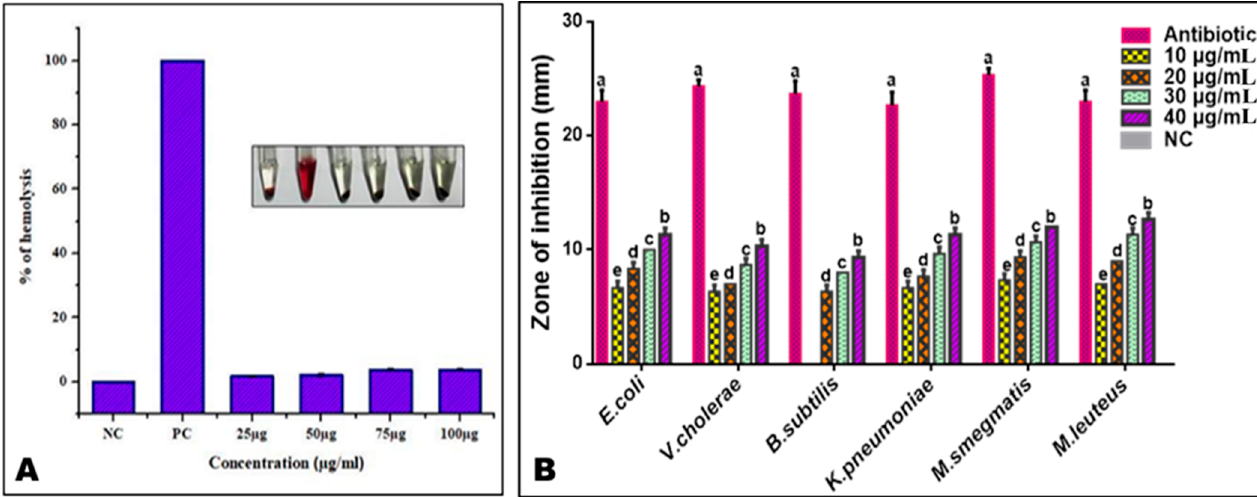
Figure 7. ( A ) Hemolytic activity of PoAgNPs. ( B ) Antibacterial activity of PoAgNPs (mean ± SE followed by different Figure 7. ( a ) Hemolytic activity of PoAgNPs. ( b ) Antibacterial activity of PoAgNPs (mean ± SE followed by different letters